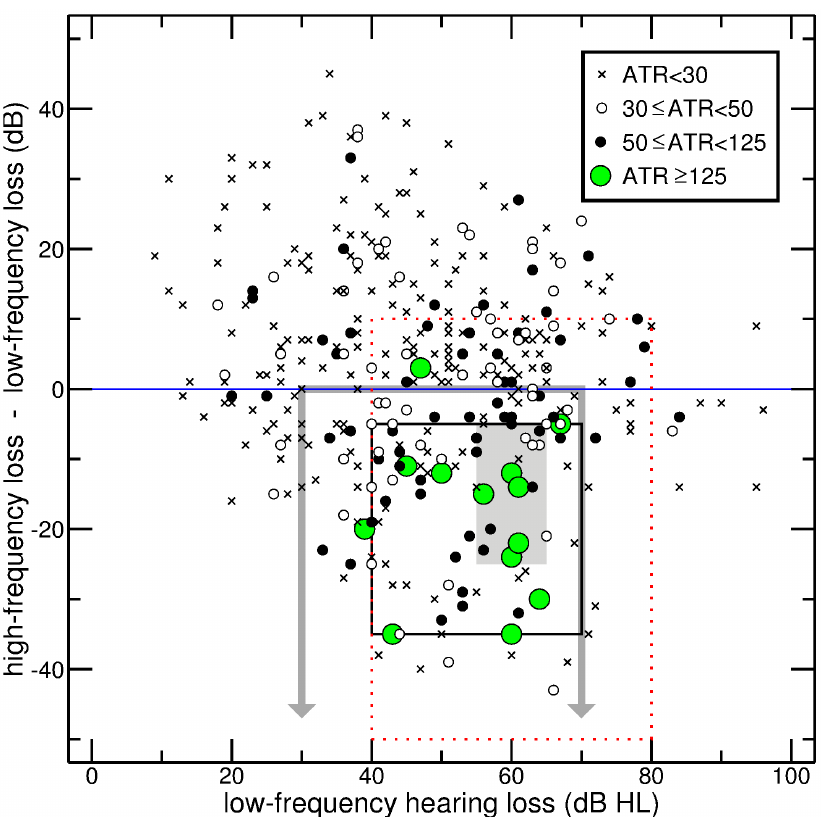
Figure 1. The results of all 356 glycerol tests projected into a two-dimensional predictor space. The two axes represent the mean low- frequency hearing loss (horizontal) and the difference between mean high-frequency and mean low-frequency hearing loss (vertical). The type of symbol indicates the aggregate threshold reduction (ATR) that was observed four hours after the glycerol intake. The gray area indicates the optimal region under the constraint that at least 5% of the cases are to be included. Optimal regions with at least 20% and 50% of the cases are bounded by solid and dotted lines, respectively. The area framed by thick gray lines with downward arrows represents a simple rule of thumb[?] according to which a glycerol test should be considered as a diagnostic option when a patient with suspected Menie`re’s disease has a mean low-frequency hearing loss between 30 and 70 dB and a mean high-frequency hearing loss that does not exceed the mean low-frequency loss.